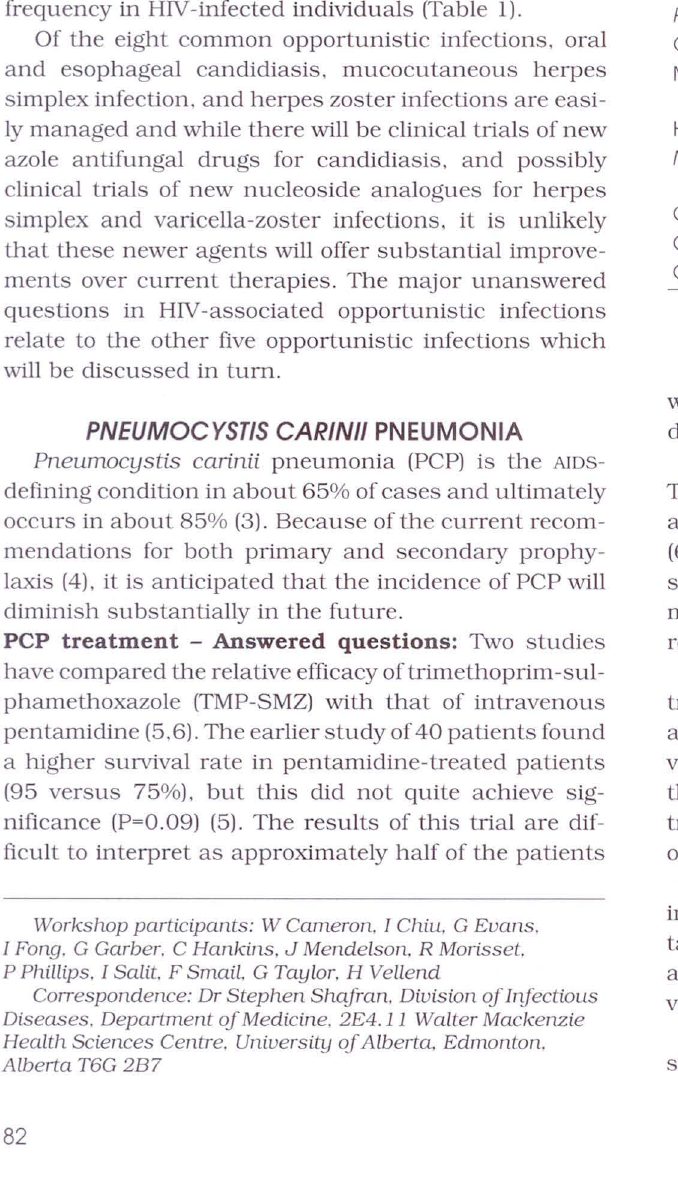
Common opportunistic infections in HlV-infected indi viduals